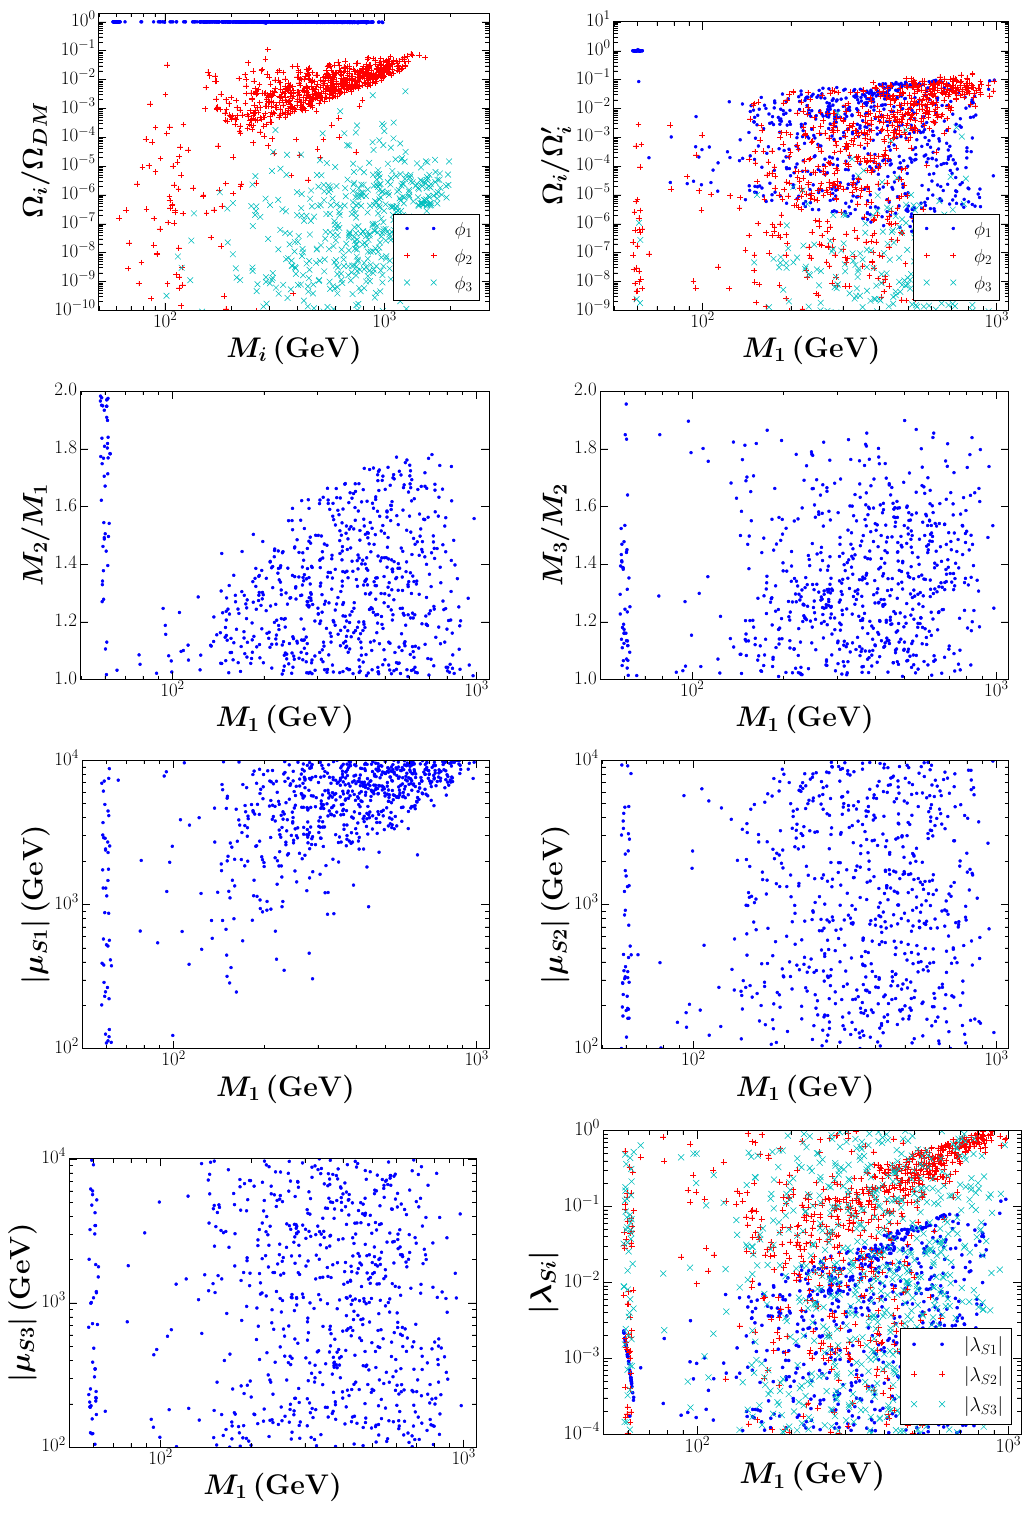
Figure 5 . The viable regions for µ S 1 6 = 0 , µ S 2 6 = 0 , µ S 3 6 = 0 (scan B). All points shown in these plots are compatible with current